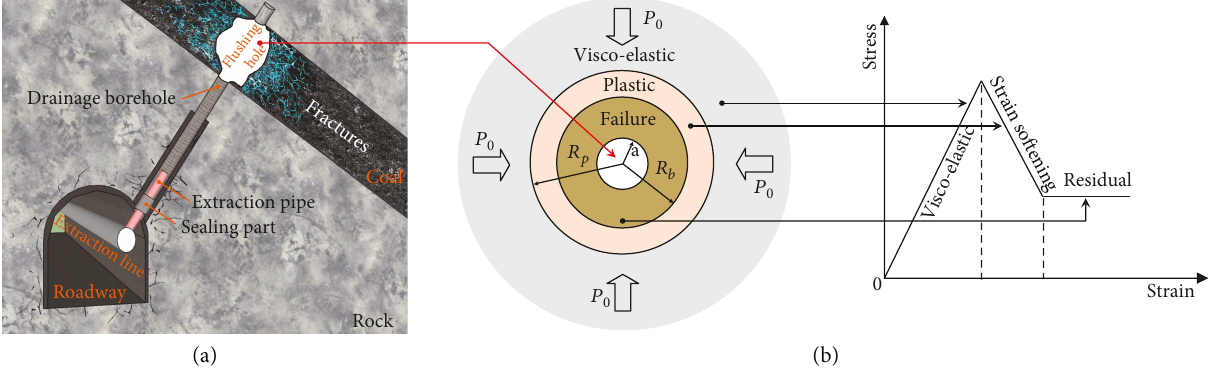
Figure 1: Schematic diagram of the HFHE-enhanced gas drainage and the elastic-plastic secondary stress distribution around an underground opening [6]. (a) Illustration of the HFHE-enhanced gas drainage. (b) Illustration of elastic plastic secondary stress distribution around an underground